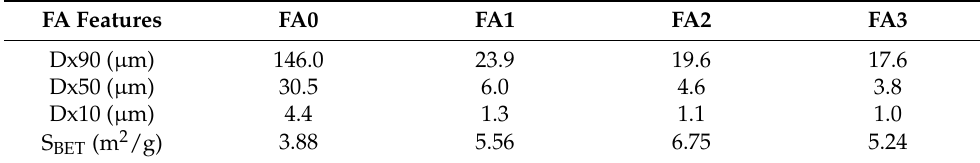
Table 2. Change in specific surface areas (S BET ) and particle diameters of FA in relation to milling